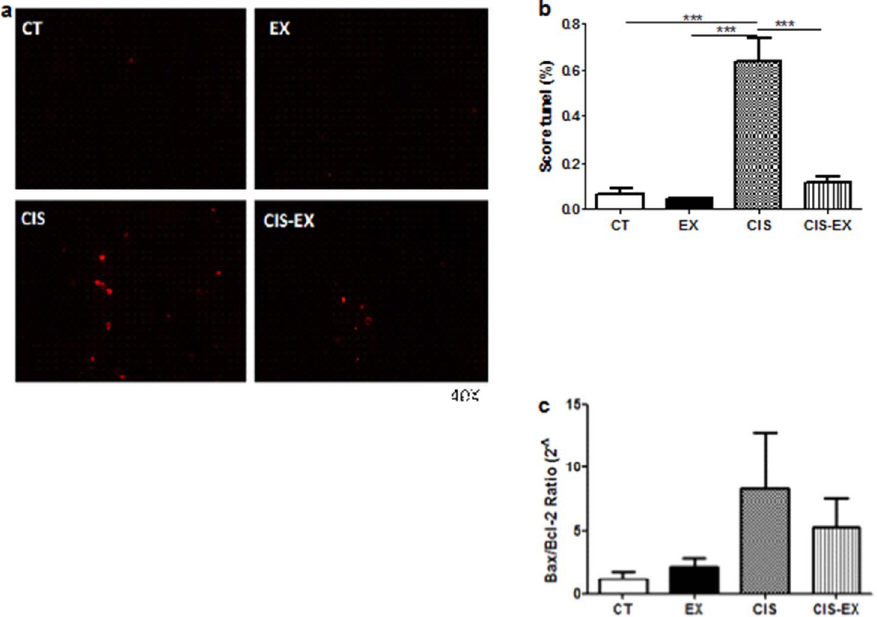
Figure 2. Aerobic exercise reduces cell death in the kidney. Representative TUNEL staining ( A ) and quantification ( B ) showed a significantly reduced percentage of TUNEL-positive cells (dead cells) in the CIS-EX group. The expression of Bcl2 and Bax genes was evaluated by qPCR and is represented by the ratio of the pro- to the anti-apoptotic molecule (Bax/Bcl2) ( C ) the CIS group was more likely to exhibit a pro-apoptotic profile, confirming the protective role of exercise. ***P , 0.001.